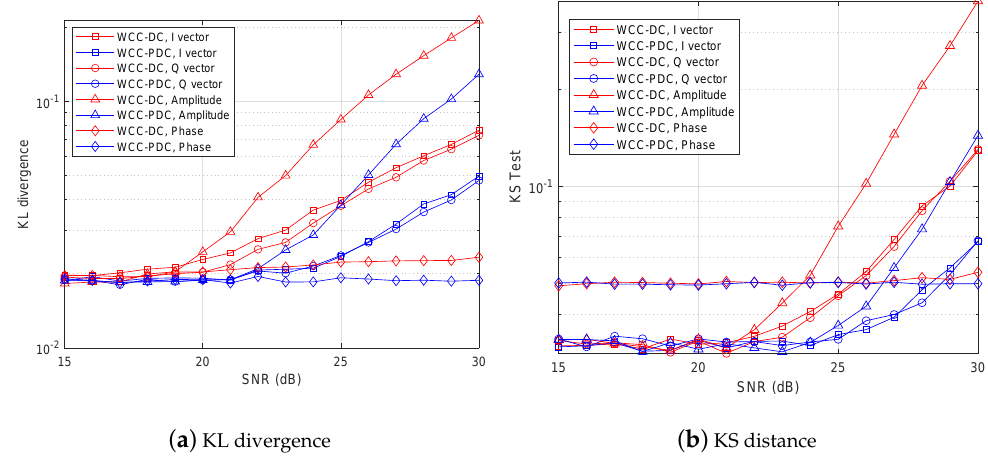
Figure 11. Detection values versus signal noise ratio at Willie, and CSR = 10 dB.